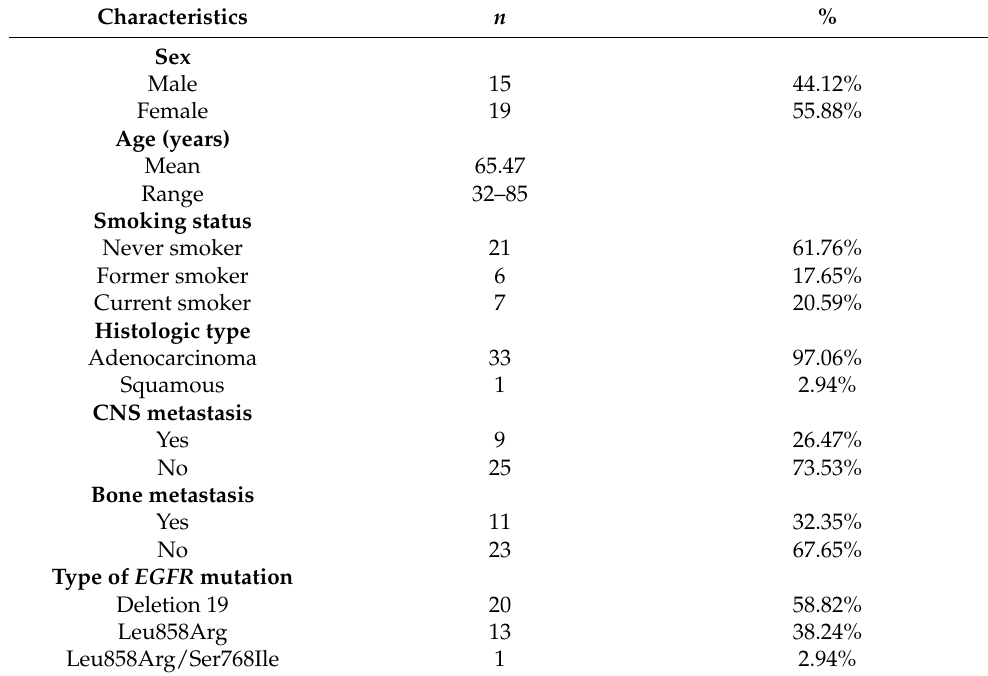
Figure 6. Flow chart showing the patients included in the pretreatment cohort. NSCLC: Non-small cell lung cancer. EGFR-TKI: Epidermal growth factor receptor tyrosine kinase inhibitor. Table 2. Epidemiological and clinical–pathological characteristics of the patients included in the pretreatment cohort.